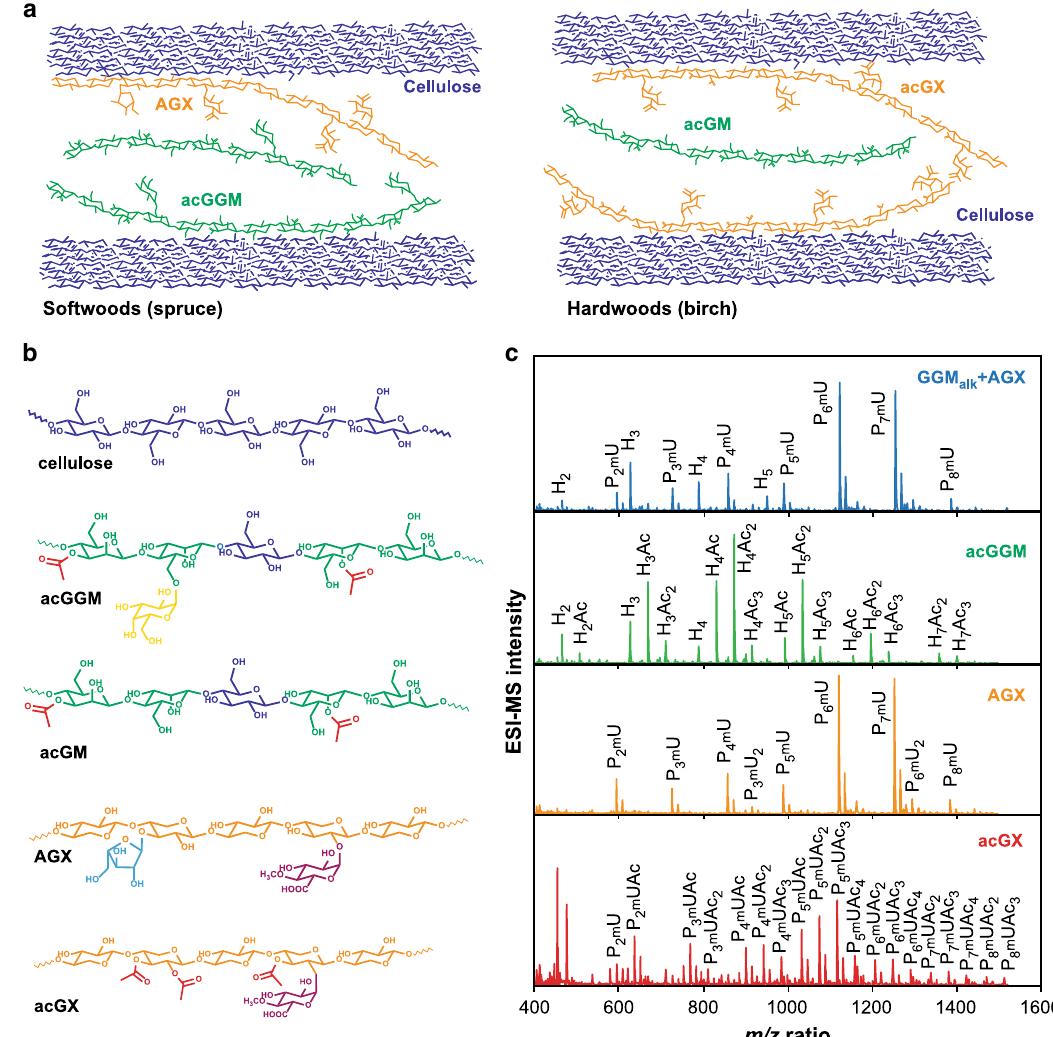
Fig. 1 Structure of wood hemicelluloses and their incorporation in BC-H model networks. a Schematic illustration of the polymeric network in a model BC-H system mimicking the secondary cell walls of softwoods and hardwoods prior to ligni fi cation. b Average molecular structure of major repeating motifs of wood hemicelluloses. Softwood O -acetyl-galactoglucomannan (acGGM, from spruce) comprises a main chain of β -(1 → 4)-linked D -mannose (Man) and D -glucose units (Glc) partially substituted by α -(1 → 6)-linked D -galactose units (Gal) exclusively on the Man units and partial acetylation at the C2 and C3 hydroxyl groups of Man 68 . Hardwood O-acetyl-glucomannan (acGM) has similar structure as acGGM without Gal substitutions. Softwood arabino-4- O -methylglucuronoxylan (AGX, from spruce) consists of a backbone of β -(1 → 4)-linked D -Xyl with partial substitution by both α -(1 → 2)-linked mGlcA and α -(1 → 3)-linked L -arabinofuranose (Ara) 10,16 . Hardwood O -acetyl-4- O -methylglucuronoxylan (acGX, from birch) consists of a backbone of β - (1 → 4)-linked D -xylose units (Xyl) with partial substitution of α -(1 → 2)-linked 4- O - D -methylglucuronic acids (mGlcA) and O -acetylation (OAc) at some of the C2 and C3 units of Xyl 13,22 . c Oligomeric mass pro fi ling (OLIMP) by mass spectrometry of the wood hemicelluloses (AGX, acGX, and acGGM) after enzymatic hydrolysis. Note: P refers to a pentose (Xyl or Ara), H refers to a hexose (Man, Gal or Glc), Ac refers to an acetyl group, and mU refers to mGlcA. Source data provided as a Source Data fi